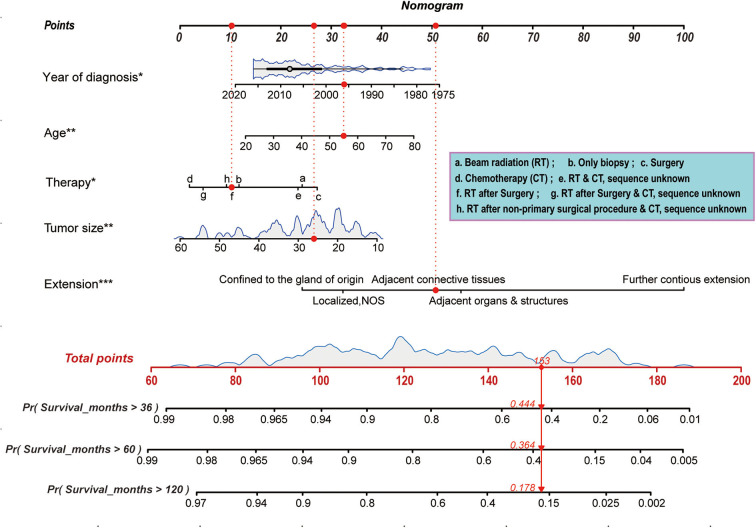
Nomogram predicting 36-, 60-, and 120-month cancer-specific survival for patients with PB. Prognostic factors including age, race, tumor extension, tumor size, and therapy, and the scores assigned on the points scale could match each level of every variable on the nomogram. Thus, a total score was obtained by adding the score from various variables or their levels. Finally, the 36-, 60-, and 120-month cancer-specific survival for each individual patient could be estimated on the basis of the total score. *p < 0.05, **p < 0.01, ***p < 0.001.